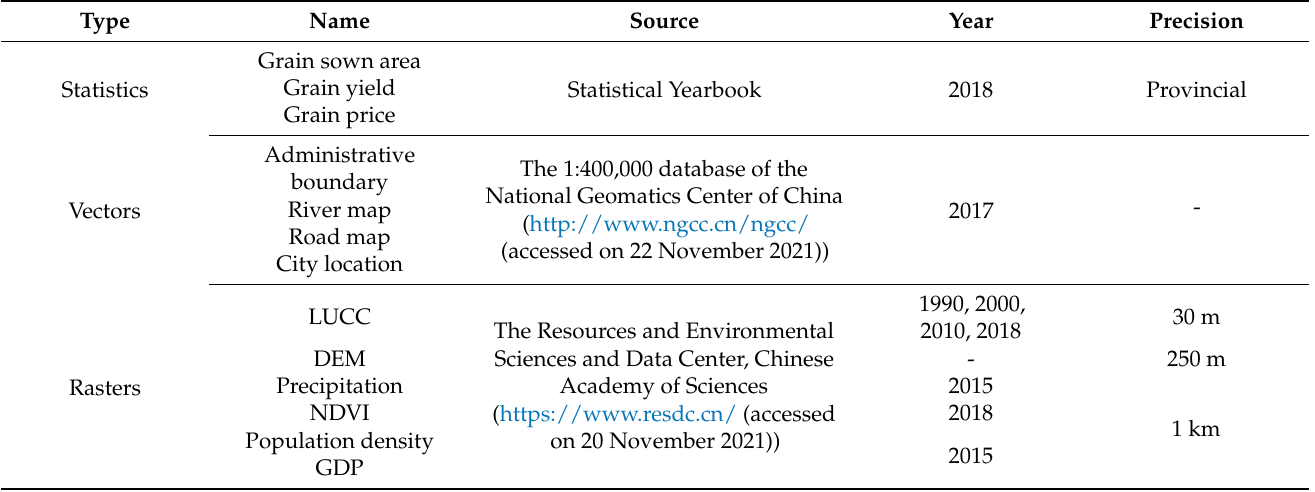
Table 1. List of basic data